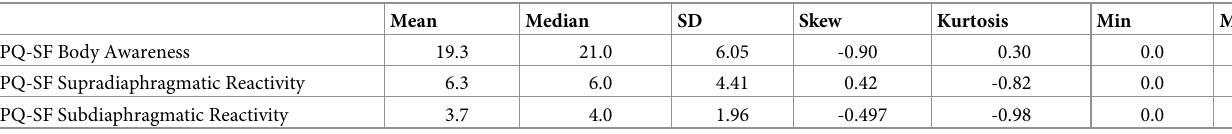
Table 4. Descriptive statistics of BPQ-SF score.